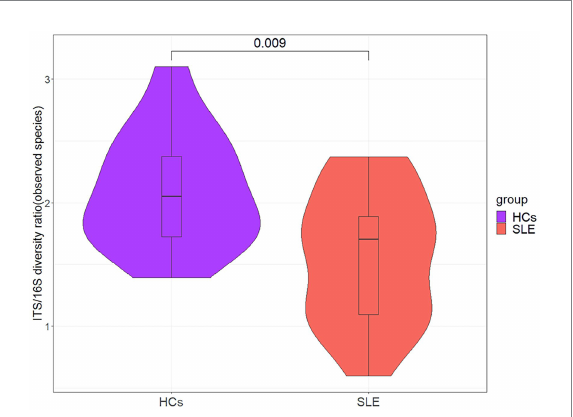
FIGURE 4 The ITS/16S diversity ratio between SLE and HCs at the genus level.